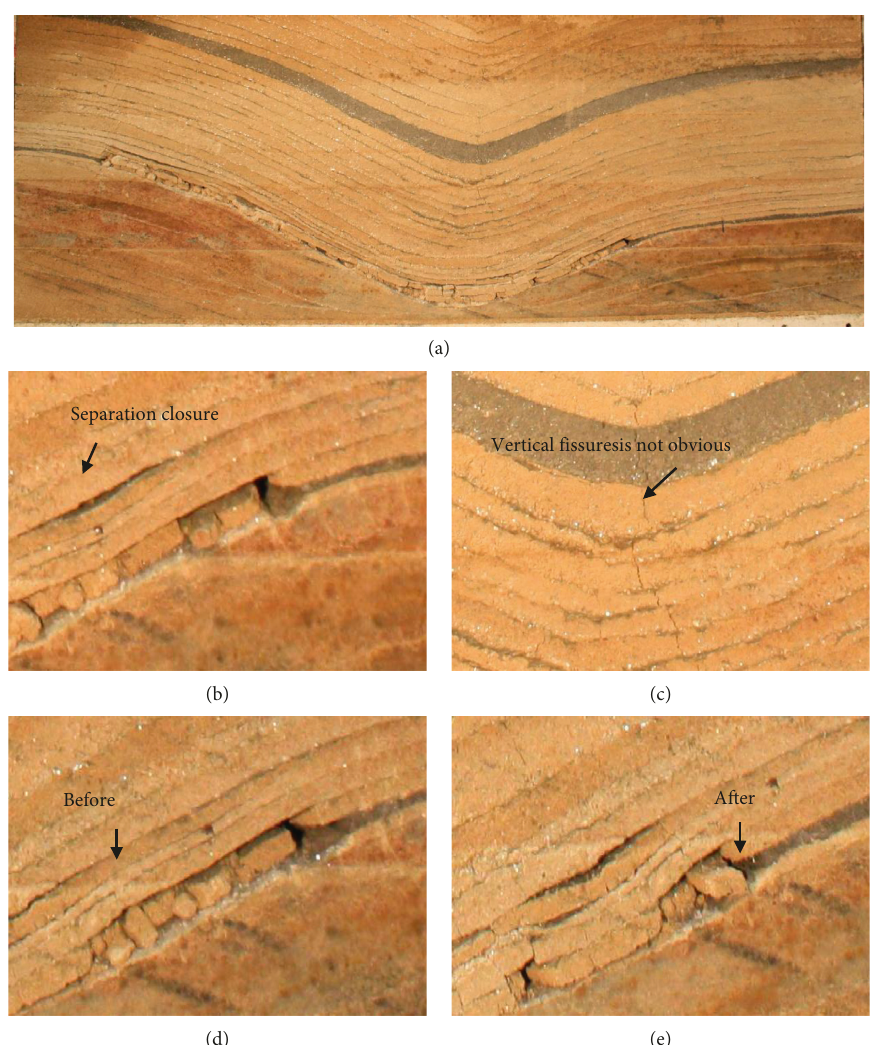
Figure 10: Periodic pressure of the main roof in the downhill mining section. (a) The whole picture of the mode. (b) Separation closure. (c) Vertical fissures of the overlying strata. (d) Before the bending caving of the main roof. (e) After the bending caving of the main